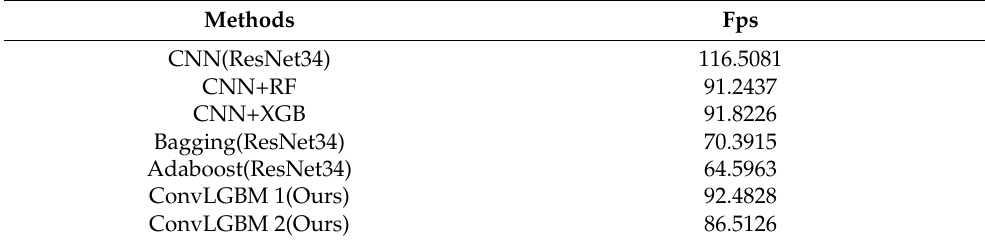
Table 7. Comparison of Fps metrics for real-time prediction by different